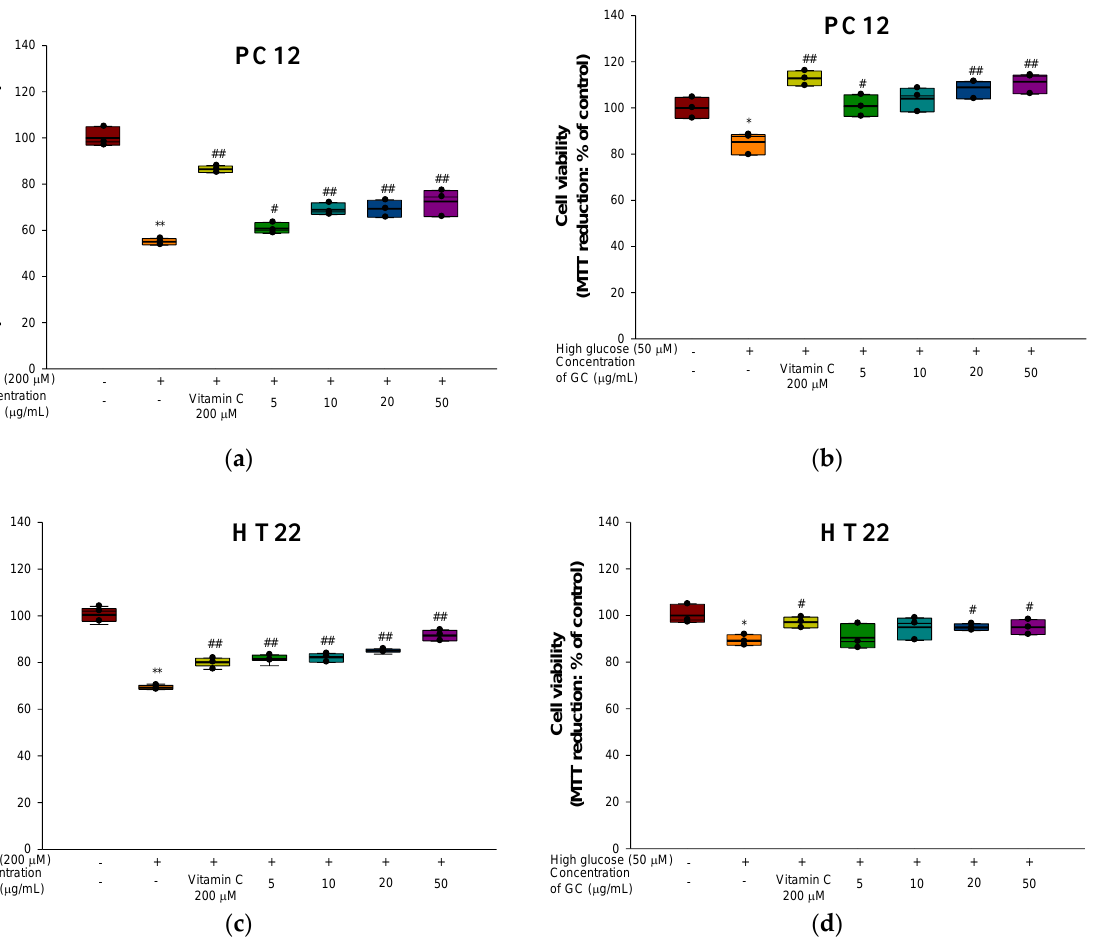
Figure 2. Protective effect of 80% ethanolic extract from Gimcheon 1ho (GC) cultivar walnut ( Juglans regia ): ( a ) cell viability from H 2 O 2 -induced cytotoxicity in PC12 cells; ( b ) cell viability from high- glucose-induced cytotoxicity in PC12 cells; ( c ) cell viability from H 2 O 2 -induced cytotoxicity in HT22 cells; ( d ) cell viability from high glucose-induced cytotoxicity in HT22 cells. Results shown are mean ± SD ( n = 3). Data are statistically represented with * = significantly different from the NC group, and # = significantly different from PM group; * and # p < 0.05, ** and ## p < 0.01. Bold line indicates mean. Intracellular ROS in the H 2 O 2 (137.83%) and high-glucose (107.52%)-treated groups increased by 37.83% and 7.52%, respectively, compared to the control group (100%) in PC12 cells (Figure 3a,b). However, the 20 μg/mL (65.88% and 81.78%) and 50 μg/mL (59.67% and 81.60%) GC groups had a decreased level of ROS production. In addition, intracellular ROS production in HT22 increased with H 2 O 2 (251.46%) and high glucose (106.27%) compared to the control group (100.00%). In contrast, GC treatment showed a remarkable reduction in oxidative stress induced by high glucose at concentrations of 20 μg/mL (75.34% and 87.74%) and 50 μg/mL (61.02% and 79.27%) (Figure 3c,d).